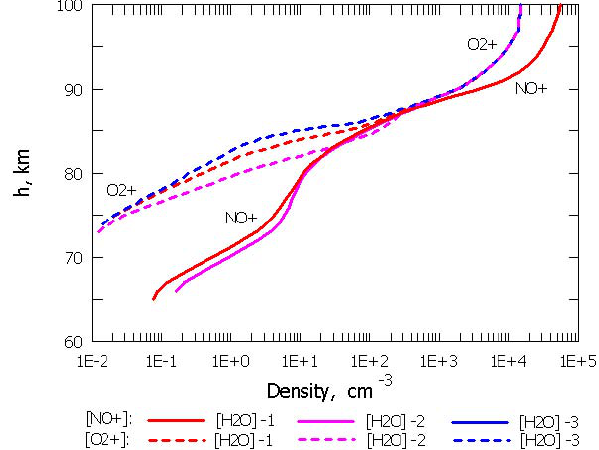
Variations in the effective recombination coefficient, α eff ,